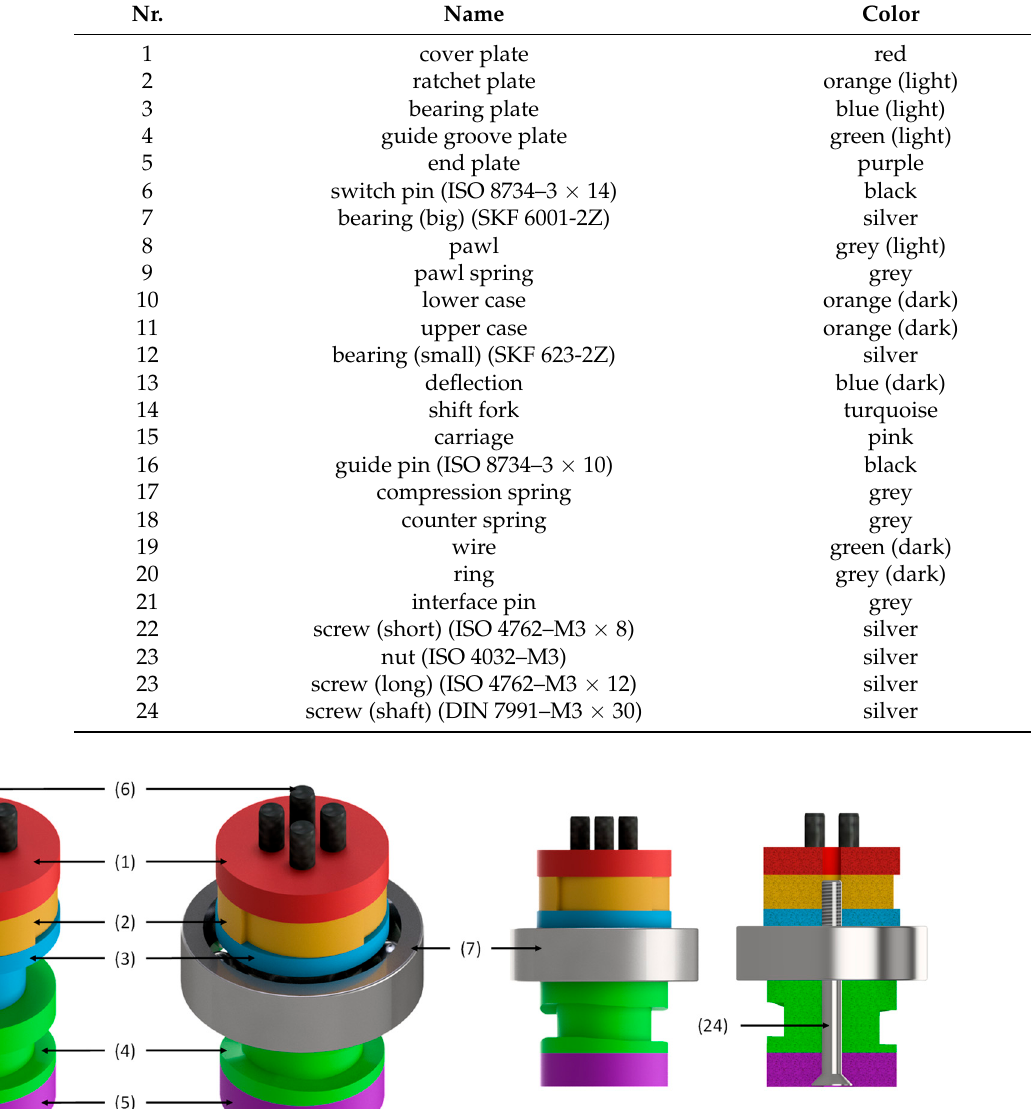
Table 3. Parts list of the actuator.